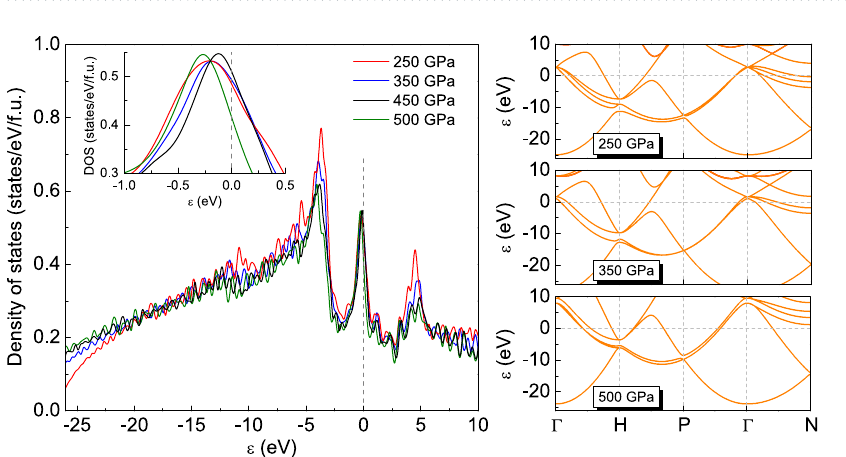
Figure 4. (Left panel) The electron density of states for the selected values of pressure. The insert presents the course of the analyzed function in the vicinity of the Fermi energy. (Right panel) The electron band energy for the selected values of